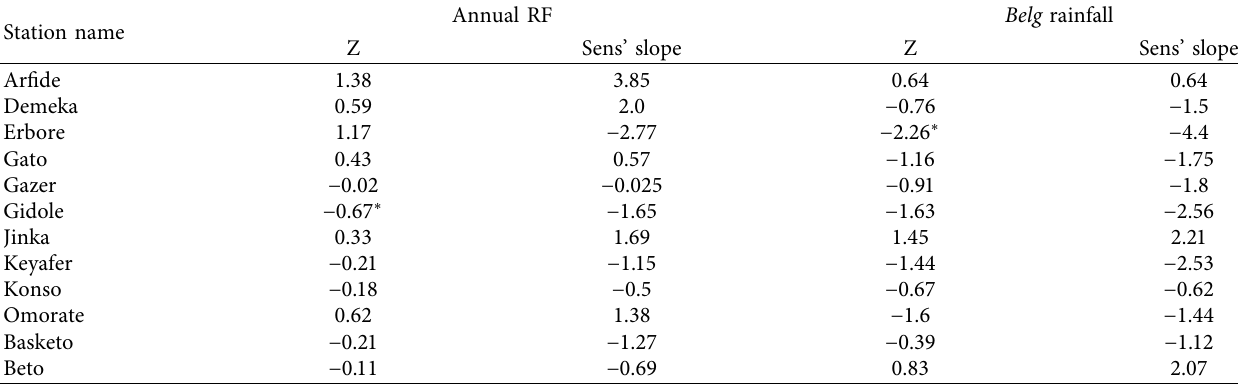
Table 1: Trends of changes on annual and Belg rainfall of weather stations in Southwest Ethiopia for the period 1983–2016.